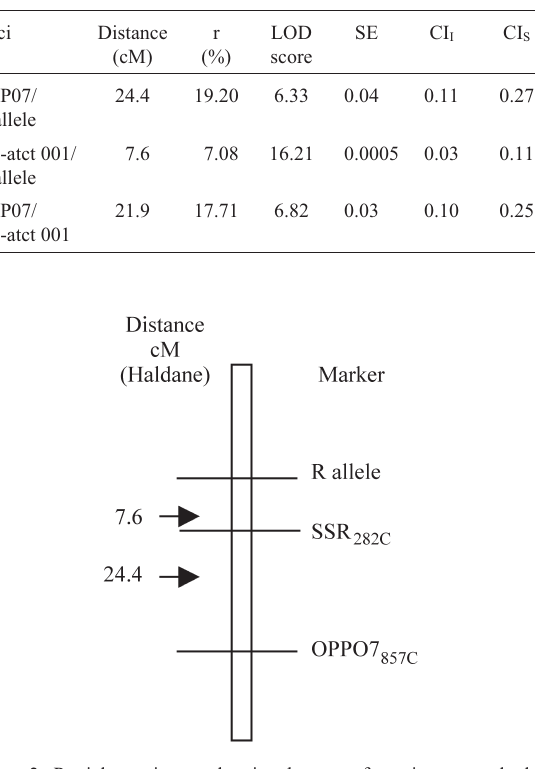
Figure 2 - Partial genetic map showing the gene of reaction to angular leaf spot and the two markers identified in the F 2:3 population of ‘ESAL 550’ x ‘Carioca MG’ cross.